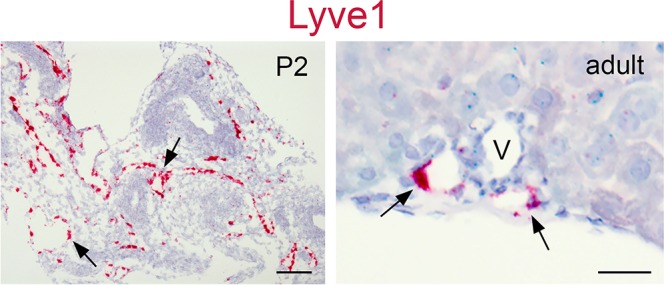
The Lyve-1 probe used for in situ hybridization in LSECs stains lymphatic endothelial cells.RNA in situ hybridization showing Lyve-1 transcript expression in peritoneal lymphatic vessels (arrows, left) from a newborn mouse and intrahepatic periportal lymphatic vessels (arrows, right) from an adult mouse. V, blood vessel. Scale bars: 100 µm (left), 25 µm (right).